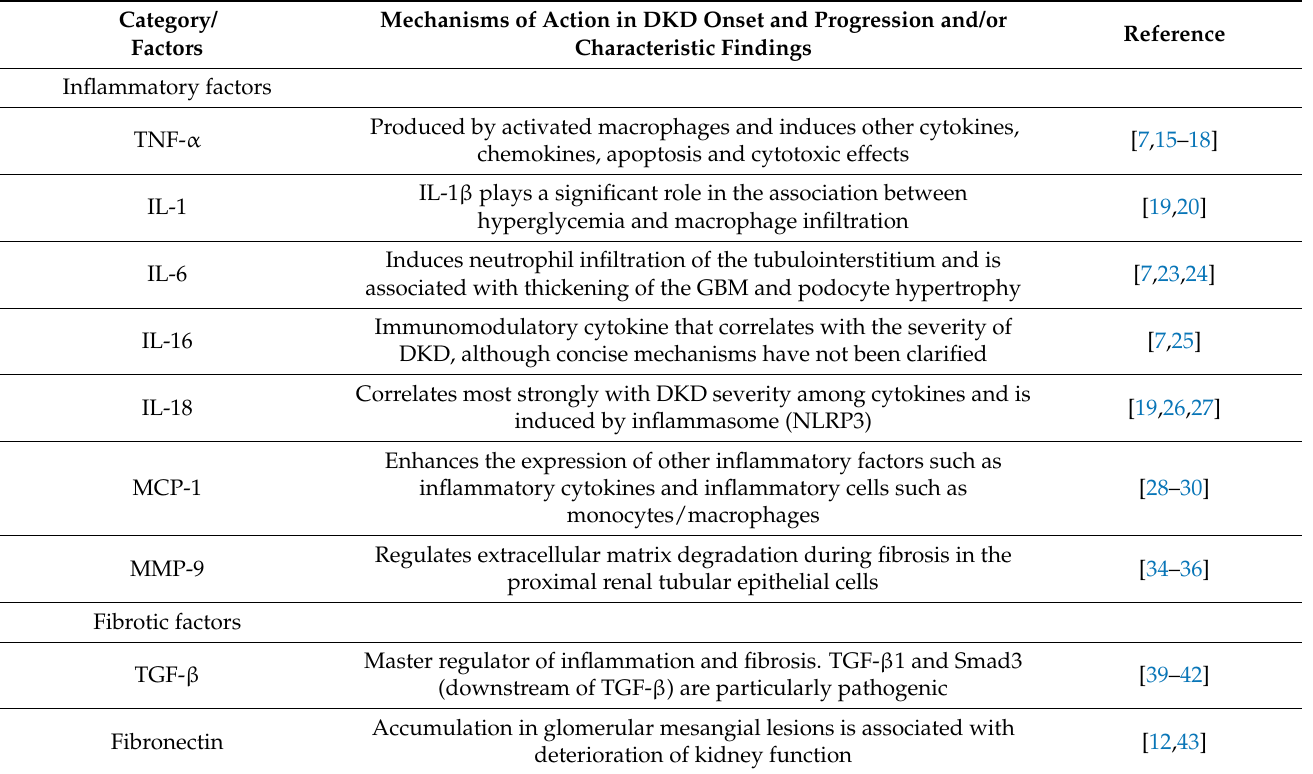
Table 1. Summary of factors involved in the onset and progression of diabetic kidney disease (DKD). Mechanisms of Action in DKD Onset and Progression and/or Characteristic Findings